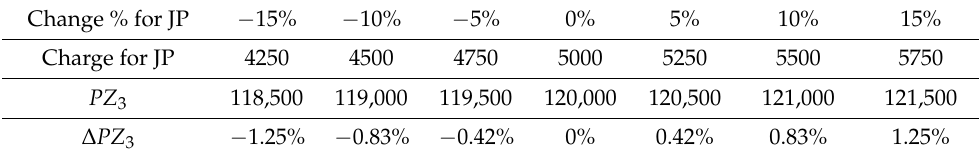
Table 6. Relational table between charge changes of junior physicians and total